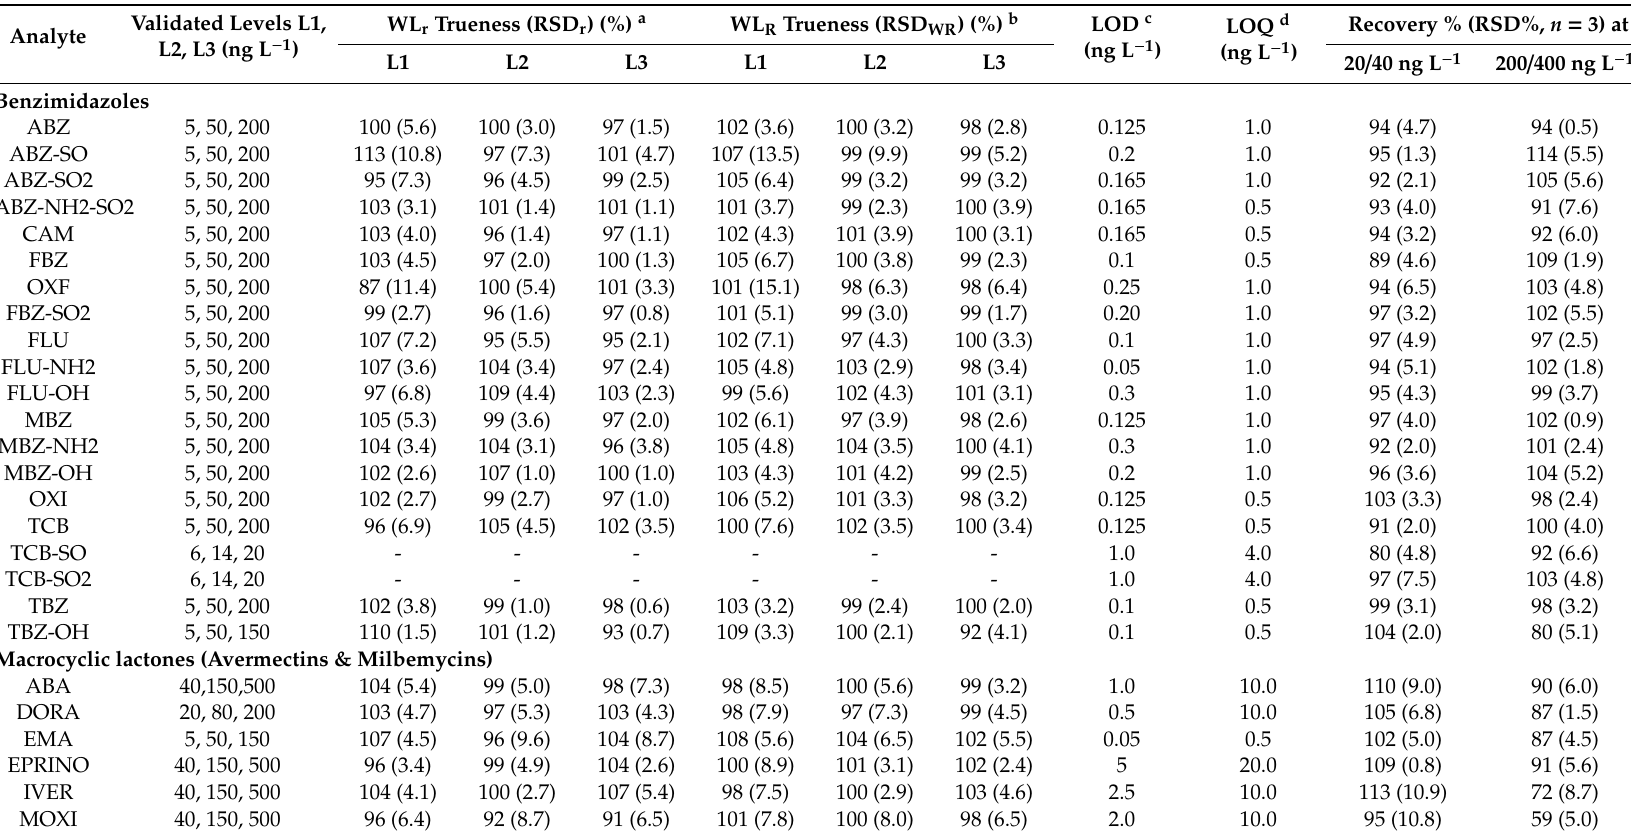
Table 3. Validation trueness and precision (RSD) under repeatability conditions (WLr) ( n = 6) and reproducibility conditions (WLR) ( n = 18) at three concentration levels for 40 anthelmintics with respective method recovery, LOD and LOQ values (ng L − 1